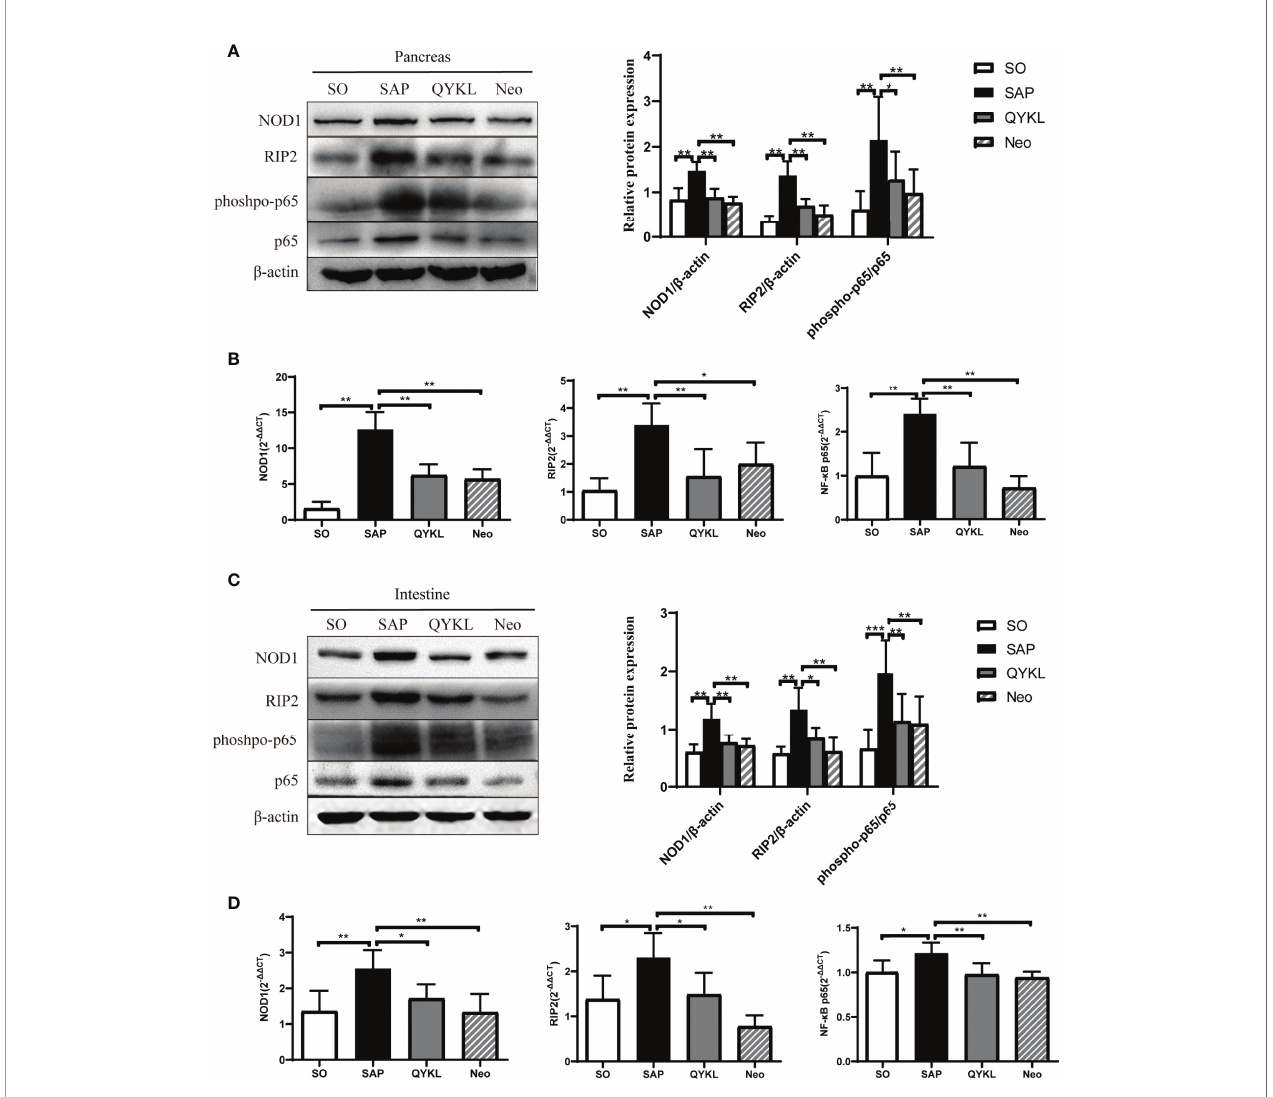
FIGURE 5 | Expression of the NOD1 signaling pathway in the pancreas and intestine. (A) Expression of NOD1, RIP2, phospho-p65 and p65 in the pancreas by western blotting; (B) Comparison of the expression levels of each mRNA of NOD1 signaling pathway in the pancreas among the four groups; (C) Expression of NOD1, RIP2, phospho-p65 and p65 in the intestine by western blotting; (D) Comparison of the expression levels of each mRNA of NOD1 signaling pathway in the intestine among the four groups. ANOVA test (n = 6 in each group); * p < 0.5, ** p < 0.01, *** p <